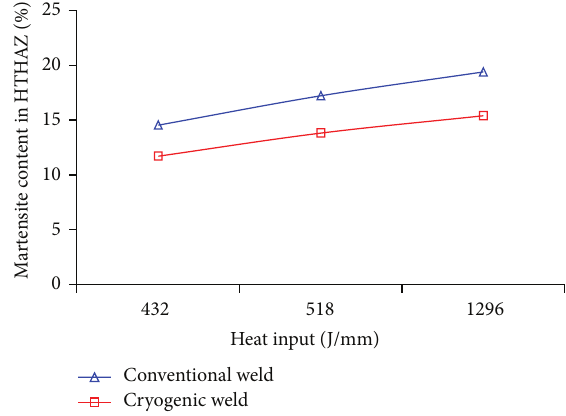
Figure 4: Martensite content in HTHAZ of the welds as a function of heat input and cooling conditions.